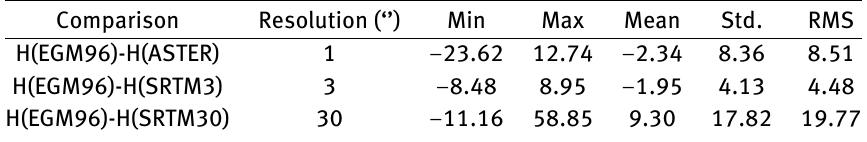
Table 1: Statistics of the model comparison with 24 GNSS/EGM96 points (Unit: m) Comparison